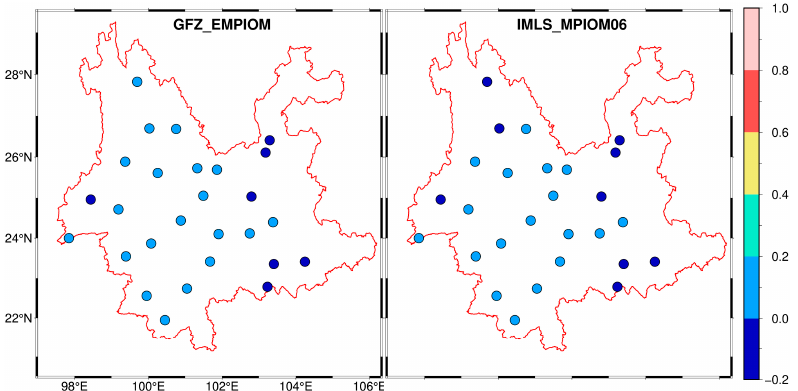
Figure 8. The correlation between two NTOL products and the vertical GPS time series at 27 GPS stations.